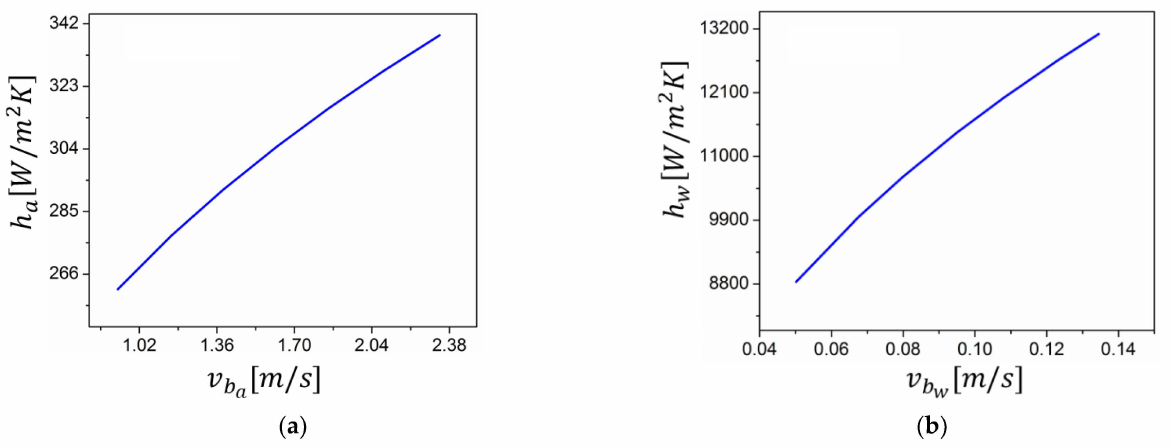
Figure 7. Convective heat transfer coefficients obtained from 3D CFD based on Equation (12) for ( a ) air side and ( b ) water